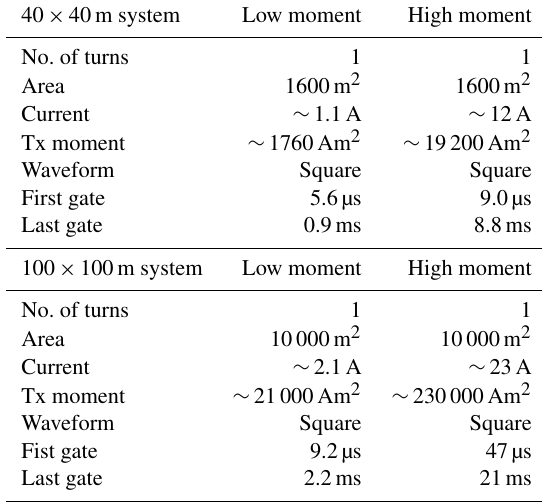
Fig. 6 represent the MRS results in the vicinity of the